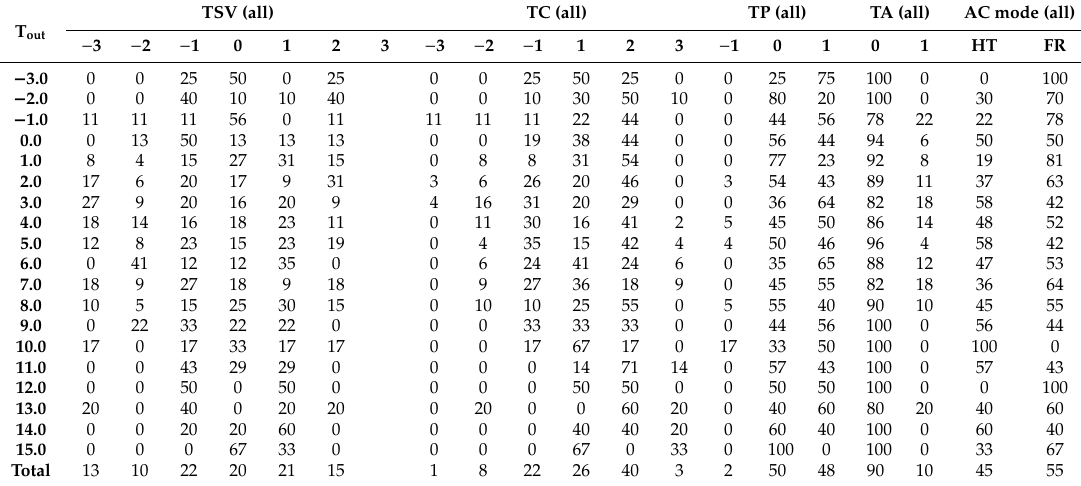
Table A3. Descriptive statistic: Thermal responses in relation to climate. Frequency distribution all winter data points (%) N = 300.